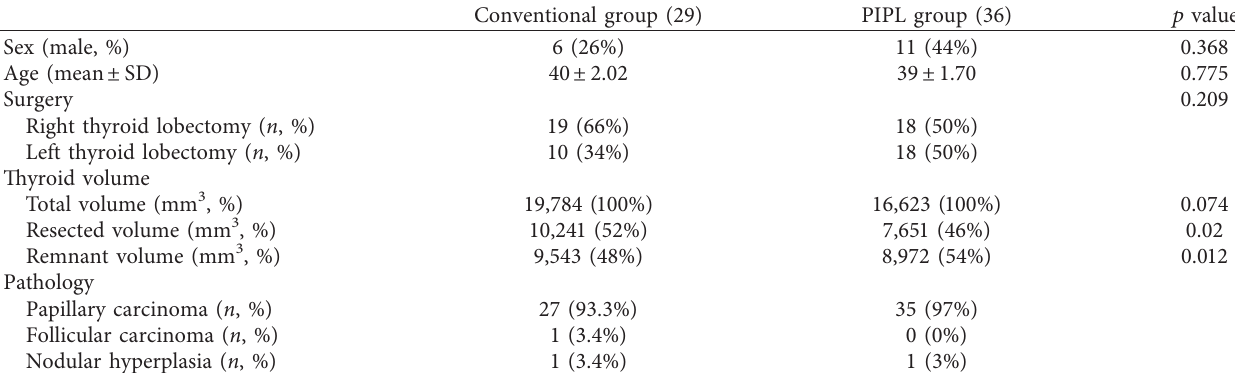
Table 1: Summary data for the